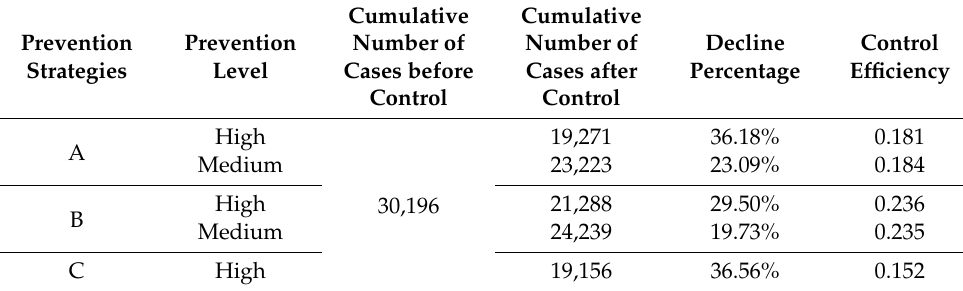
Table 10. Comparison of control